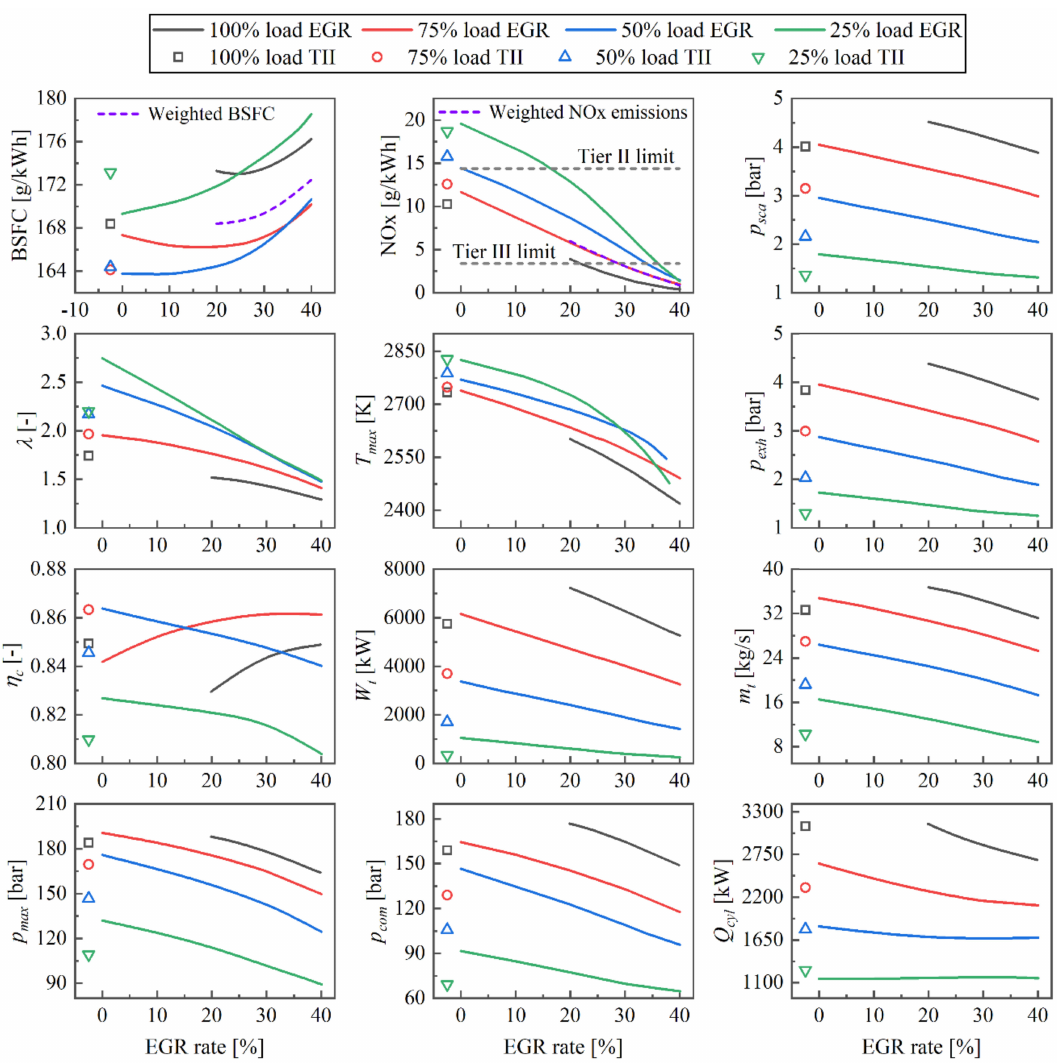
Figure 10. Effects of AL-EGR on engine performance and NOx emissions ( Q cyl , cylinder heat transfer